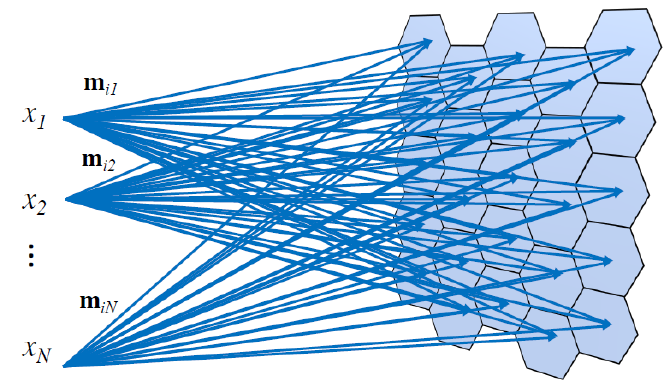
Figure 7. Structure of an SOM with N inputs, x = ( x 1 , x 2 , · · · , x N ) , and M = 25 output neurons distributed into a 5 × 5 two-dimensional hexagonal